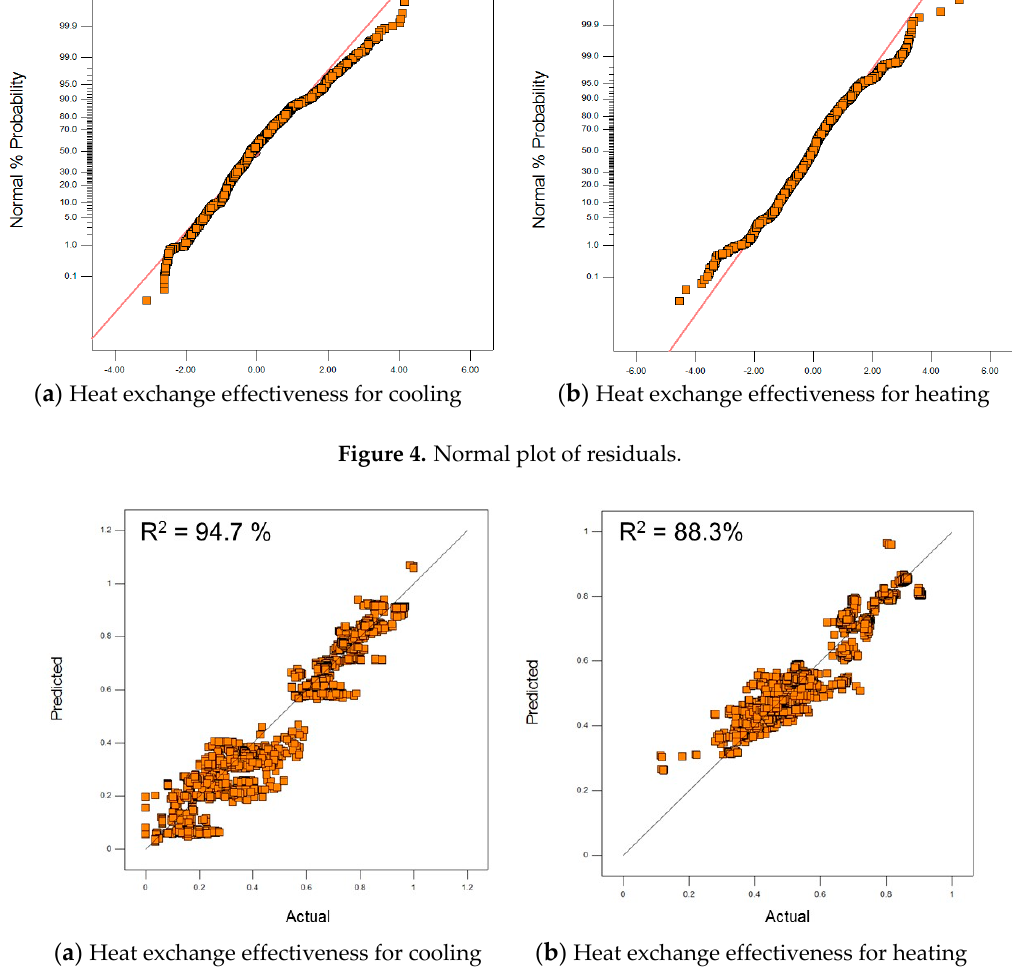
Figure 5. Comparison of predicted heat exchange effectiveness with experimental results.